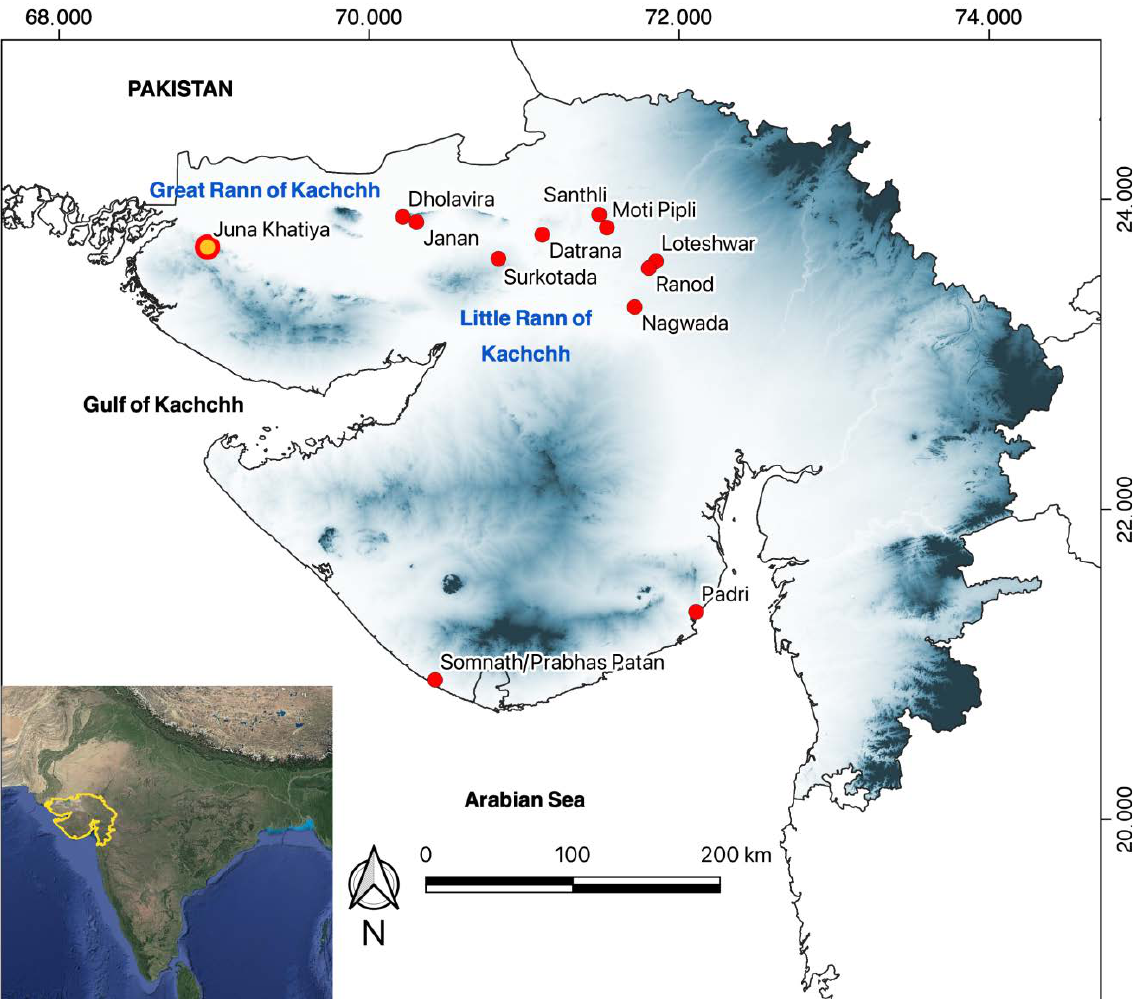
Figure 1: Map of Gujarat showing Early Harappan sites.©Abhayan,